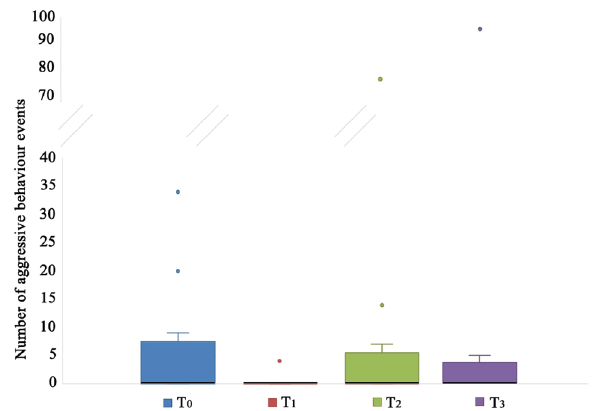
Figure 2. Aggressive behaviour towards humans of dogs receiving olive oil as a placebo at the start of the study (T 0 ), after 15 (T 1 ) and 45 (T 2 ) days from the beginning of the treatment, and 15 days after the end of the administration of olive oil (T 3 ). The black bars within the box plots indicate the median; the dots represent the